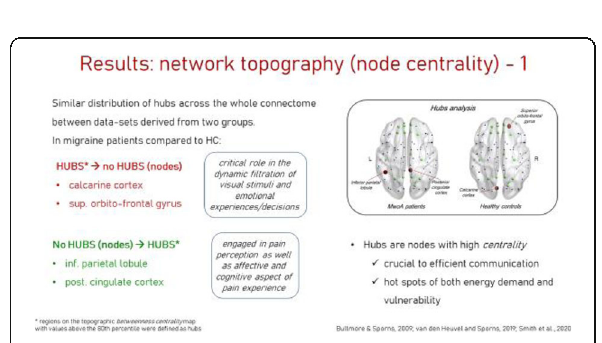
Fig. 2 (abstract P157). See text for